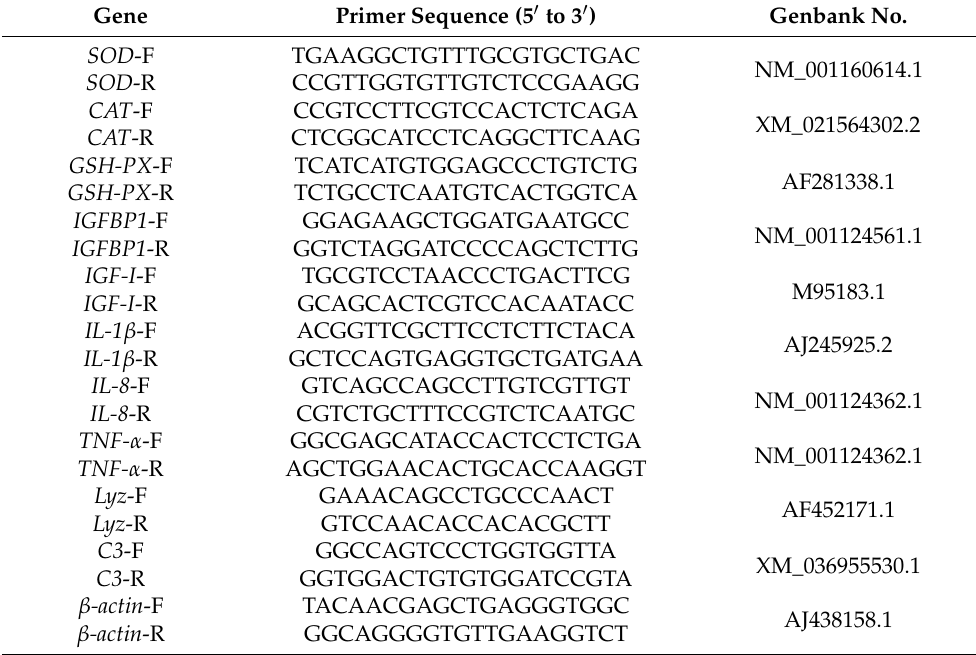
Table 2. Primer information of real-time fluorescent quantitative PCR. Gene Primer Sequence (5 (cid:48) to 3 (cid:48) ) Genbank